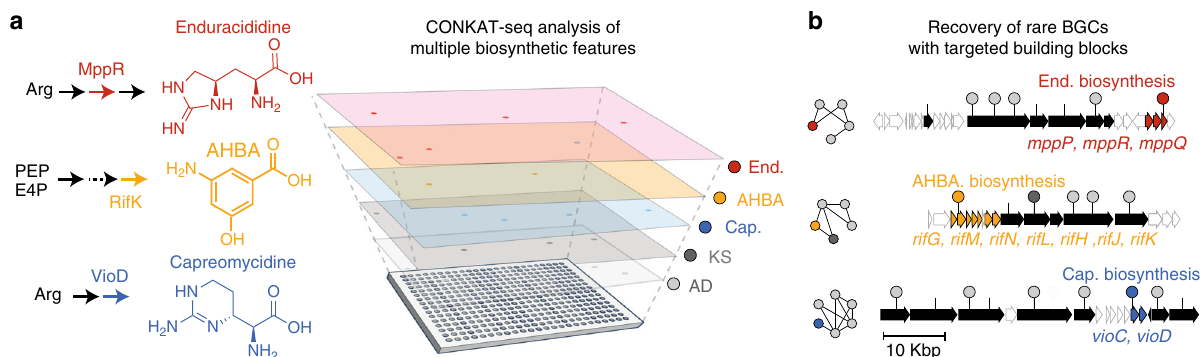
Fig. 4 CONKAT-seq identi fi es BGCs encoding for small molecules with desired chemical features in the soil metagenome. a Using a collection of two or more conserved genes targeted by degenerate primers CONKAT-seq reconstructs the chromosomal association of multiple biosynthetic domains. We designed three primer pairs and performed PCR ampli fi cation of conserved enzymes in the biosynthesis of molecular building blocks for secondary metabolites: MppR (enduracididine), VioD (capreomycidine), and RifK (3-amino-5-hydroxybenzoic acid, AHBA). By analyzing the co-occurrences frequencies of the resulting amplicons with amplicons of other biosynthetic domains (e.g., AD or KS domains), CONKAT-seq identi fi es BGCs that speci fi cally incorporate these molecular building blocks in their molecular product. b Examples of three BGCs that were recovered from the soil metagenome based on CONKAT-seq